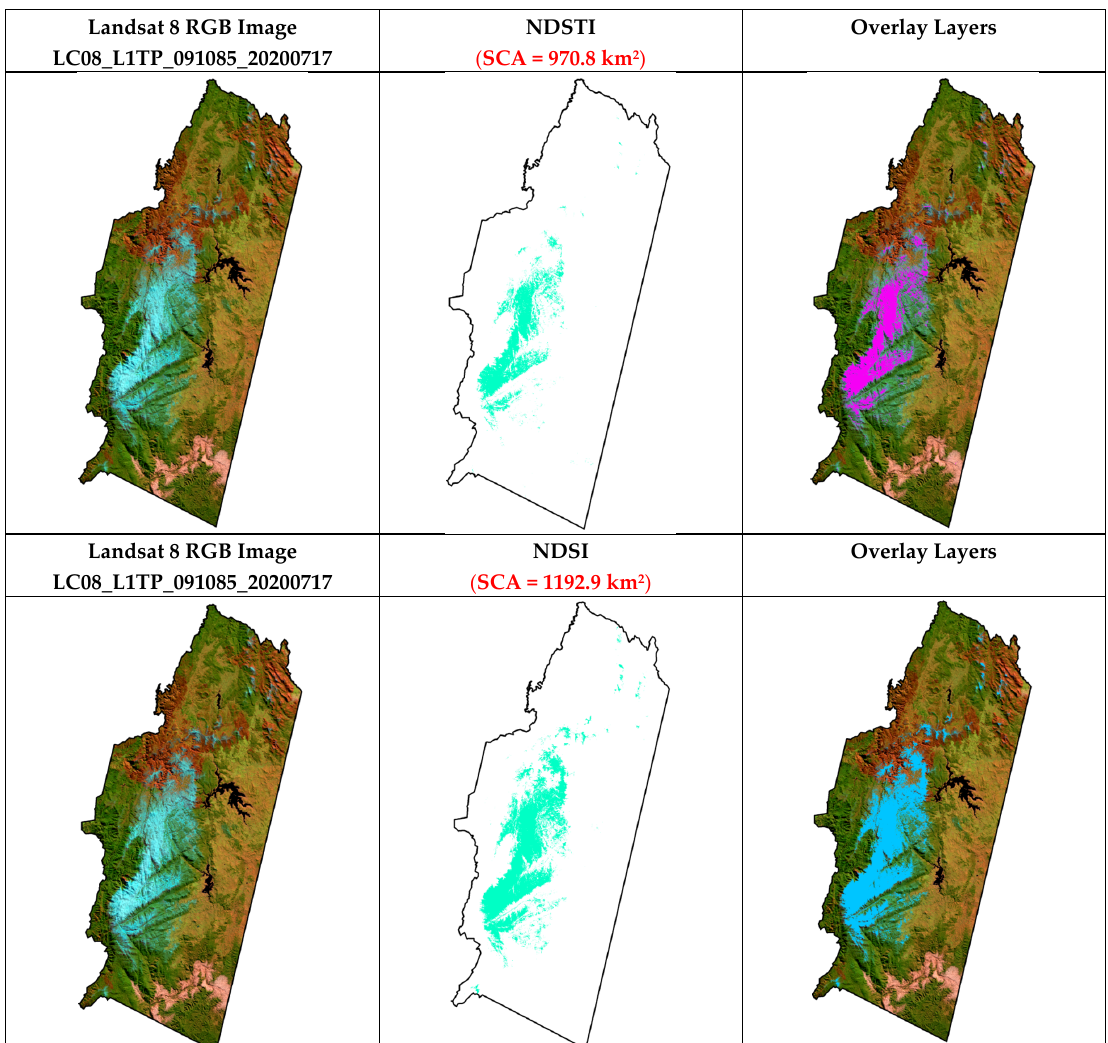
Figure A5. As in Figure A4, but for two times on the 17 July 2020.